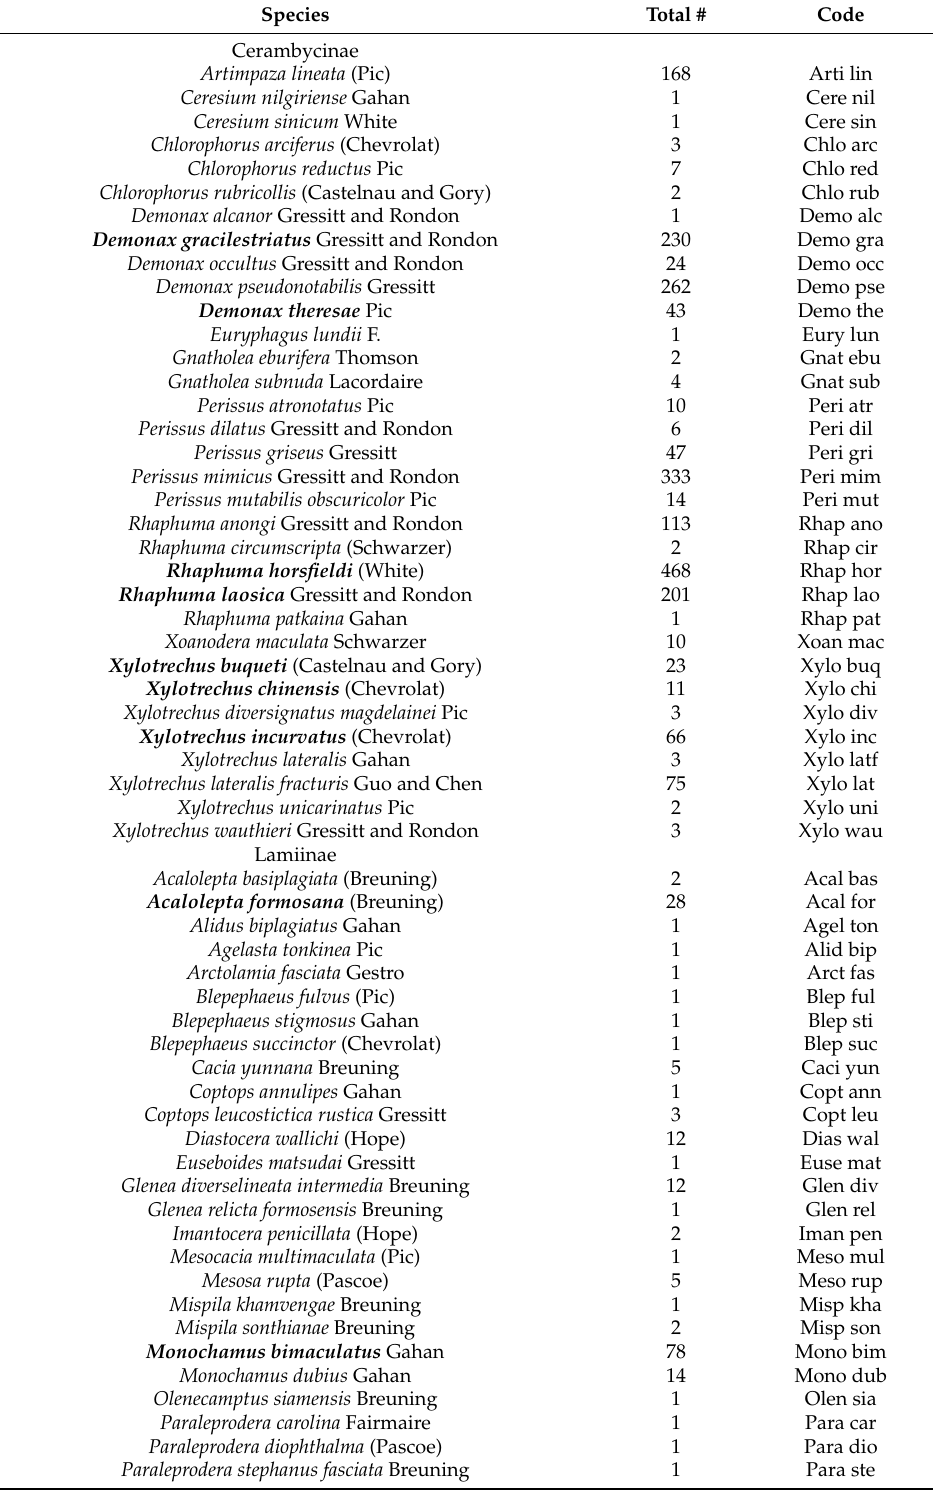
Table 1. Total numbers of each of the 71 species of cerambycids caught at 22 field sites in traps baited with multicomponent pheromone lures, and the code used for species names. At each site, 3 traps were deployed ~1 m above ground, and another 3 traps were hung at ~18 m high in the canopy. Species caught in numbers of 10 or more for which pheromones or likely pheromonal attractants have been identified previously are shown in bold